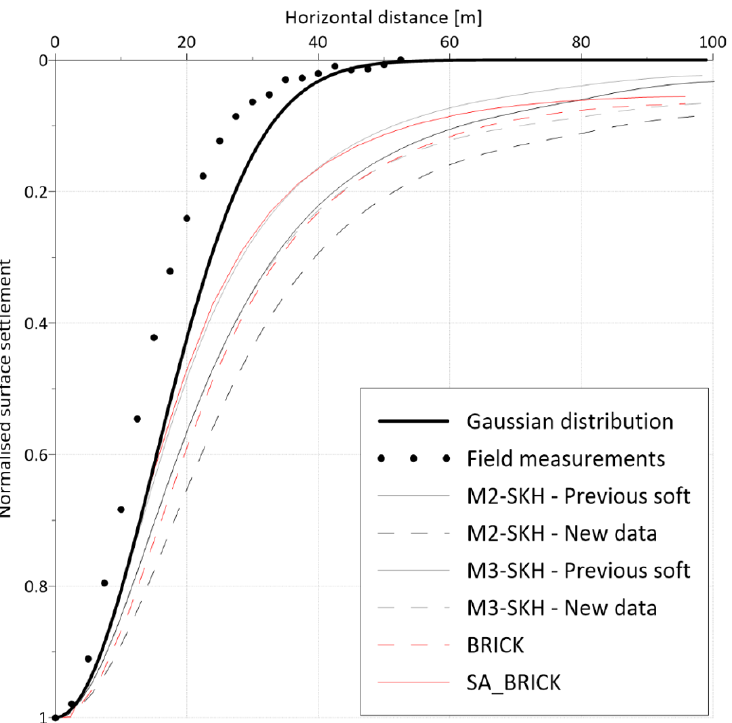
Figure 15. Normalized diagrams of the results of modelling of the excavation of the west tube compared with the Gaussian distribution and field data.